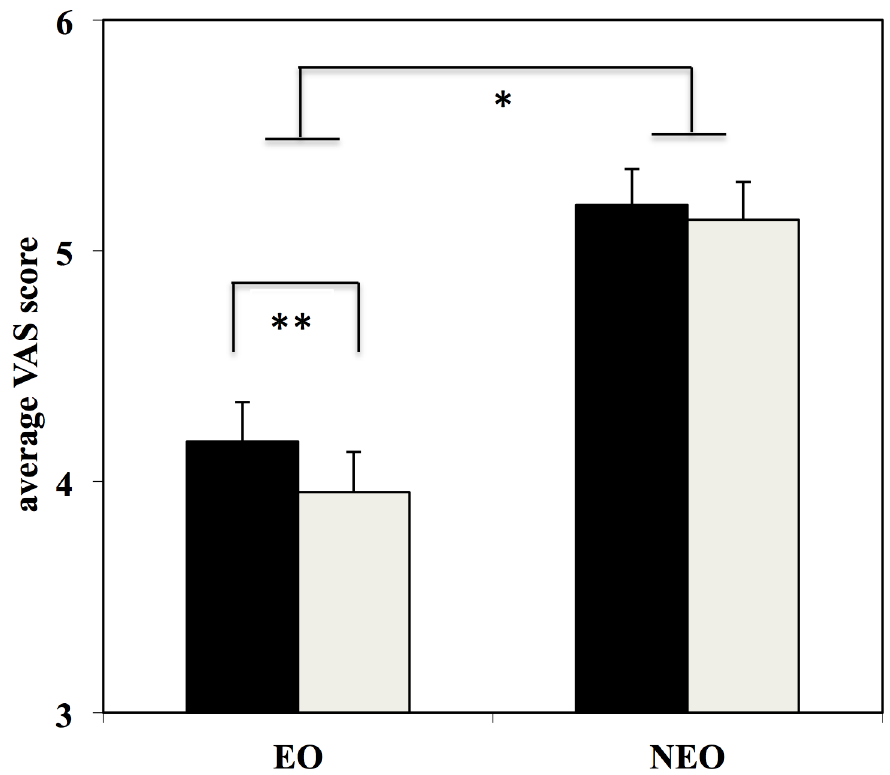
Fig 1. Average VAS score for the two groups of observers (expert observers: EO; non expert observers: NEO). Black columns represent evaluations for technical movement qualities while white columns indicate evaluations for aesthetic movement qualities. Bars represent 1 SE. * indicates significant differences between groups (EO and NEO); ** indicates significant differences between aesthetic and technical